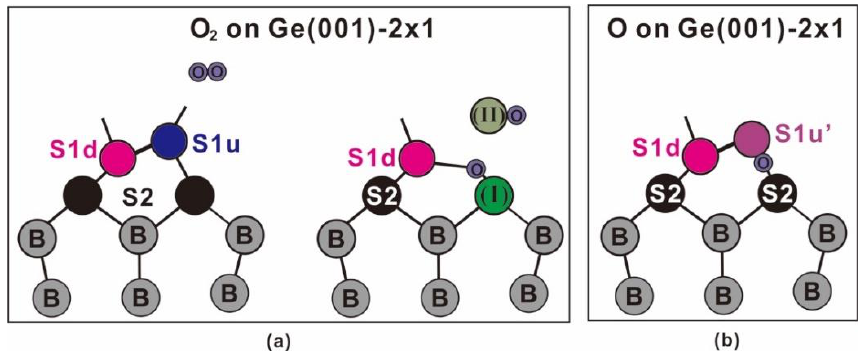
Figure 4. Schematic drawings of ( a ) O 2 onto Ge(001)-2 × 1, and ( b ) atomic O on Ge(001)-2 × 1 bonding configuration.